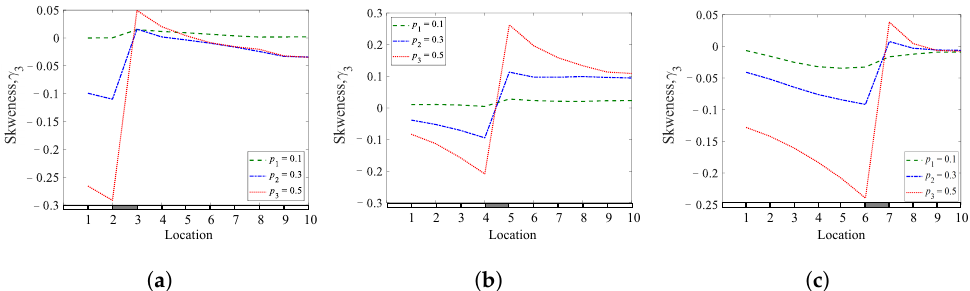
Figure 19. Skewness coefficients of a simply supported beam for different crack depths and locations: ( a ) q 1 = 0.25; ( b ) q 2 = 0.45; ( c ) q 3 =